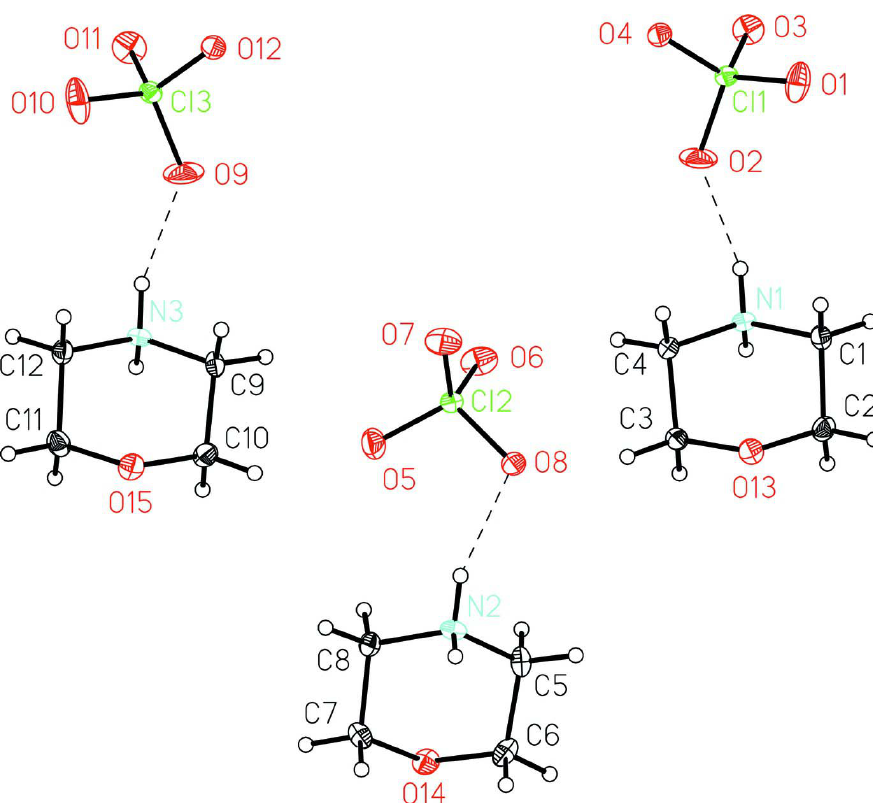
Figure 1 A view of (I), showing the atom-labelling scheme. Displacement ellipsoids are drawn at the 50% probability level and H atoms are represented by circles of arbitrary size. Dashed lines indicate the hydrogen-bonding